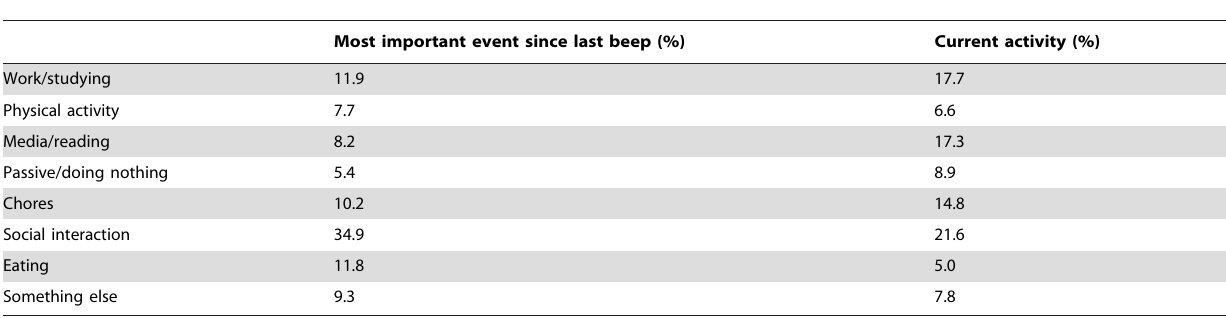
Table 2. Proportion of each activity or event of all beeps across all